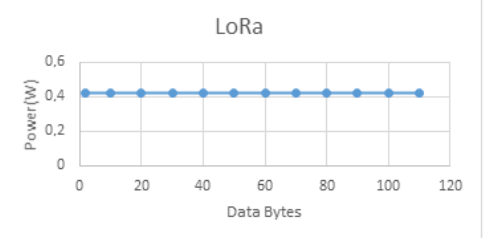
Figure 15. The energy consumption comparison charts with the LoRa module under a 1.7 km distance.